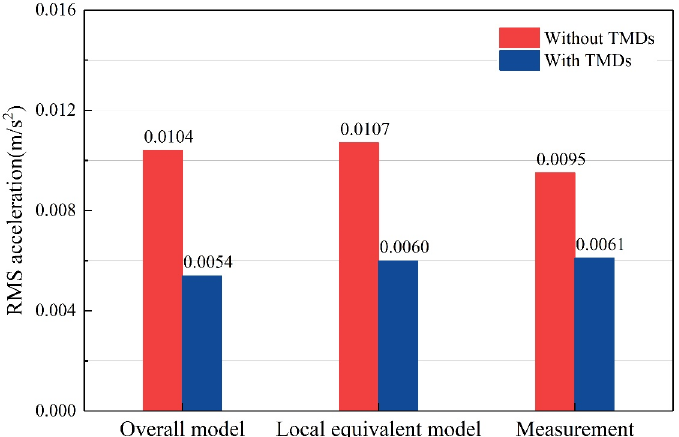
Figure 19. Comparison of RMS acceleration predicted with two FE models and corresponding field test results of the suspended floor with and without TMDs under case WP-1.